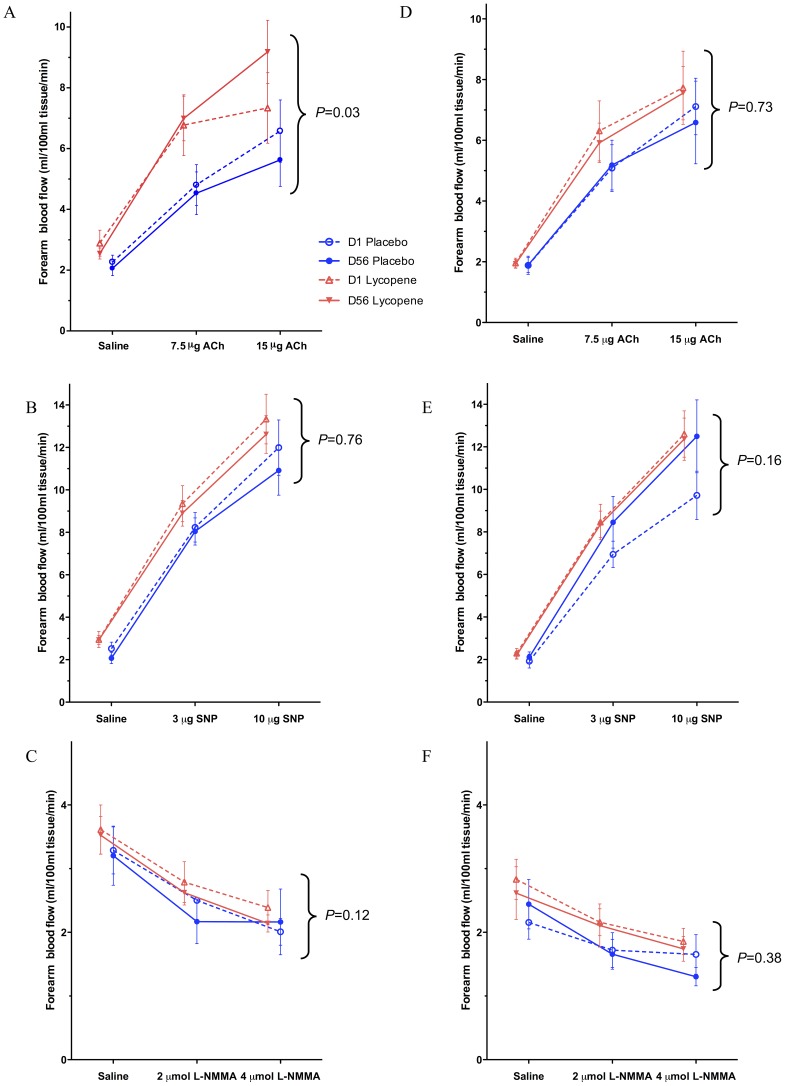
Changes in Forearm Blood Flow.Infused arm forearm blood flow values in cardiovascular disease patients (A–C) and healthy volunteers (D–F) before dose on day 1 (broken lines) and after dose on day 56 (solid lines) for lycopene (red lines) and placebo (blue lines) in response to acetylcholine (ACh; graphs A and C); sodium nitroprusside (SNP; graphs B and D), and NG-monomethyl-L-arginine (L-NMMA; graphs C and F) infusions. Values represent mean with standard error (SE) bars. Comparisons were made using a repeat measures ANOVA with terms for drug/placebo, visit day, infusion dose within day, and interaction of treatment and dose within day, in which baseline saline was treated as infusion dose zero. P-values presented are for lycopene vs. placebo overall for the higher dose challenge agent.